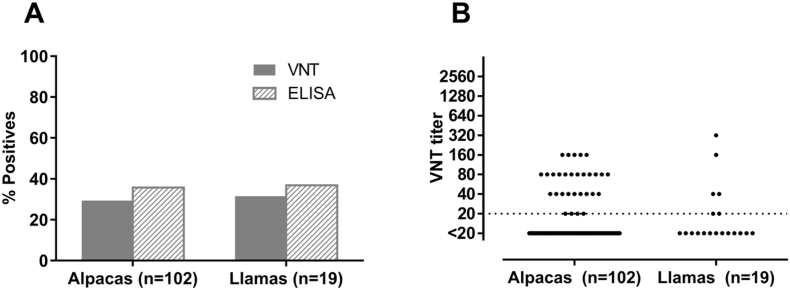
Detection of MERS-CoV antibodies in sera of alpacas and lamas by the VNT and ELISA. A) Percentage of MERS CoV antibody positive by VNT and ELISA per year. B) Serum neutralizing antibody titers by VNT. Dotted black line at 20 indicates cutoff for the VNT assay.